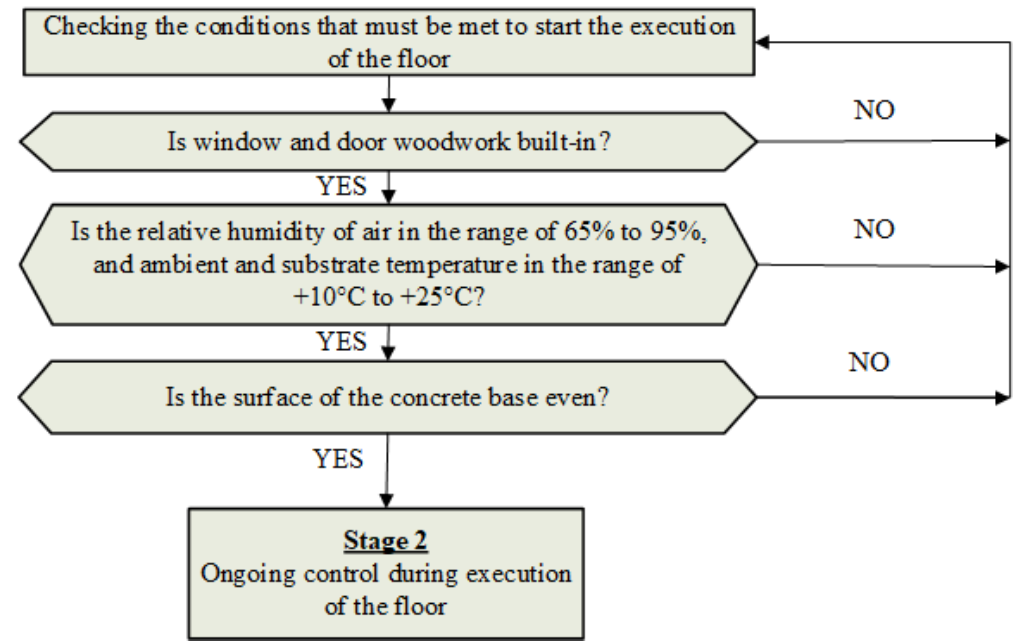
Figure 3. Methodology of controlling the technological process of executing floors made of cement-based materials—Stage 1 (control before starting the floor).